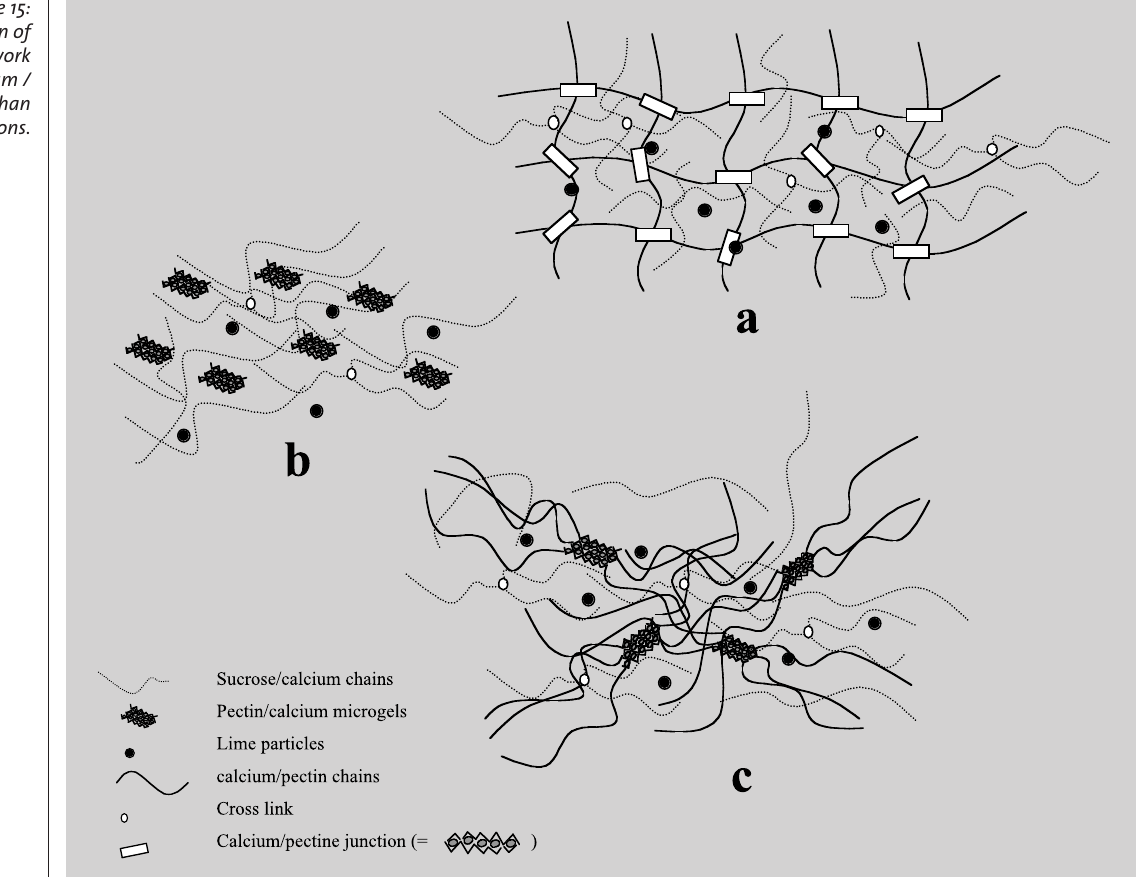
Figure 15: Schematic representation of the hypothetic network formed by the calcium / sucrose / pectin or xanthan